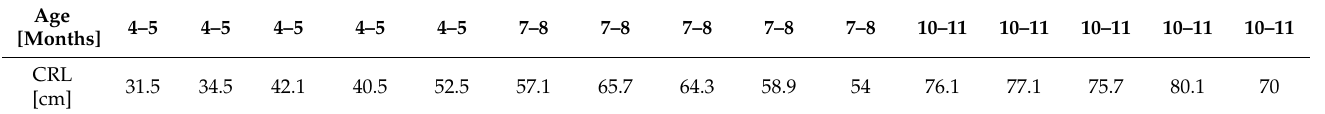
Table 5. Crown-rump length of equine foetuses.